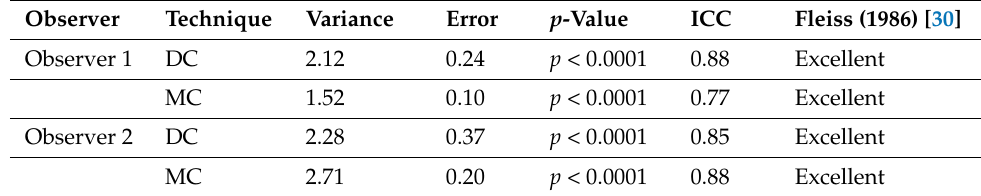
Table 2. Intraobserver ICC.